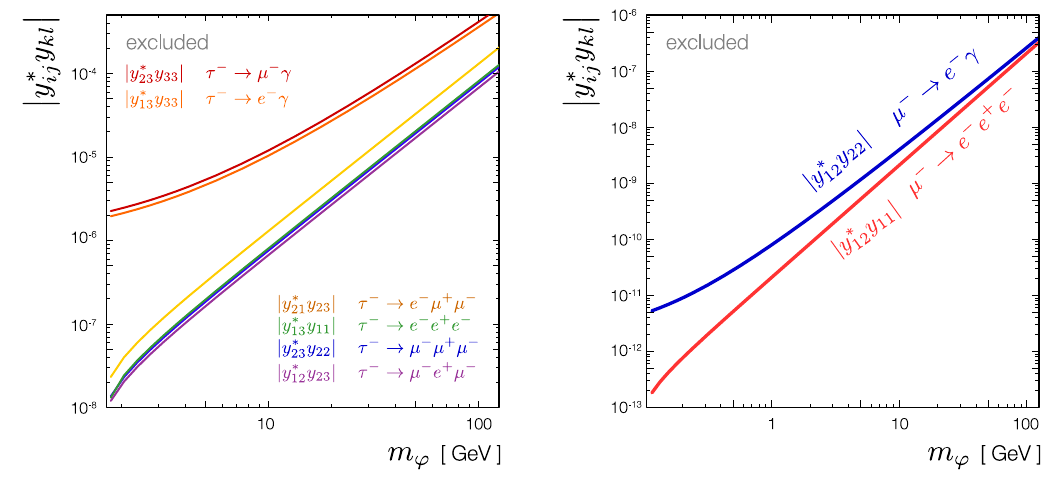
(cid:12) (cid:12) (cid:12) y (cid:3) ij y kl (cid:12) as a function of mass. Left: lfv constraints from (cid:28)